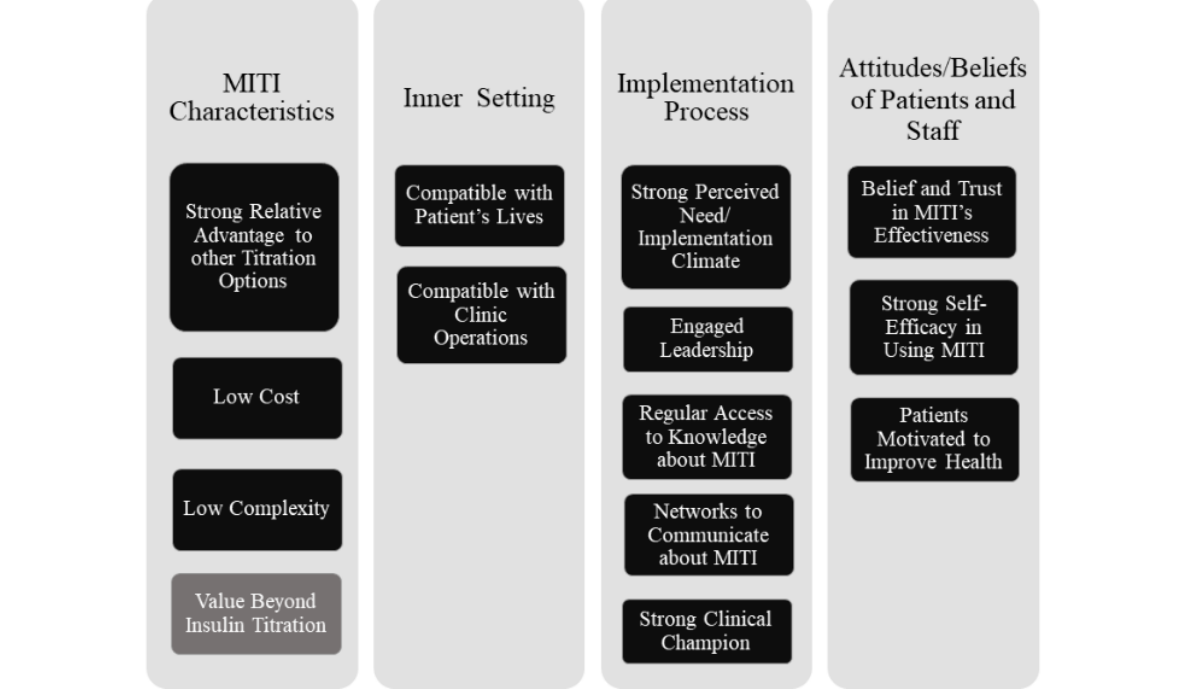
Facilitators: Mobile Insulin Titration Intervention